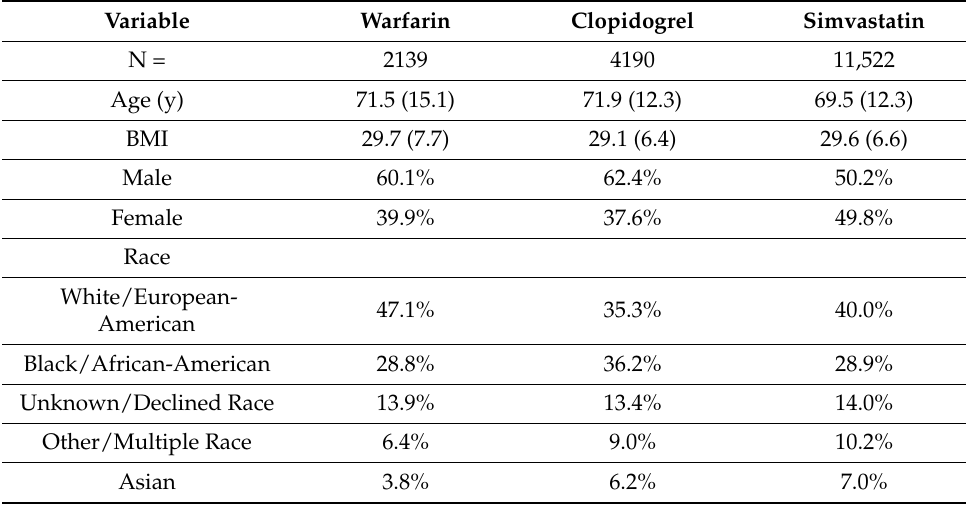
Table 1. Characteristics of study